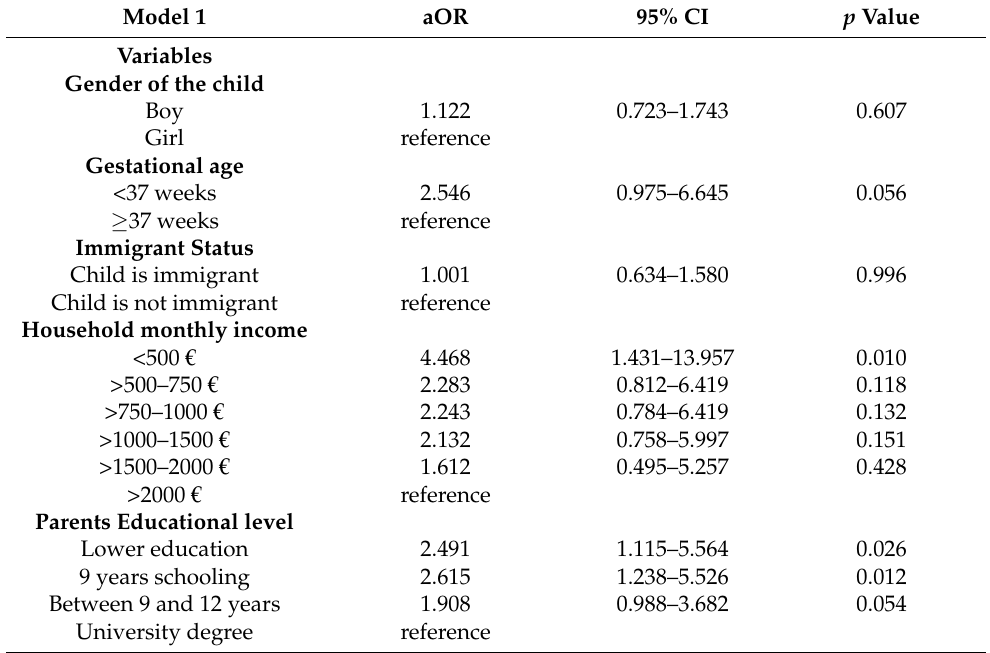
Table 6. Factors associated to the chance of developing emotional and behavioral problems; immi- grant status variable: immigrant